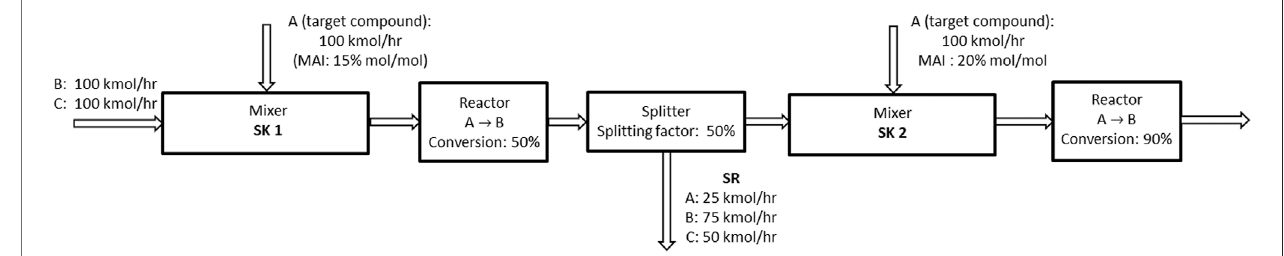
FIGURE 3 | Exemplary process for illustration of tightening and relaxing MAI constraints in the SMI RPM solution procedure. The process sources and sinks are highlighted as well as the two maximum allowable impurity levels. The source has an impurity level of 83.3% mol/mol.